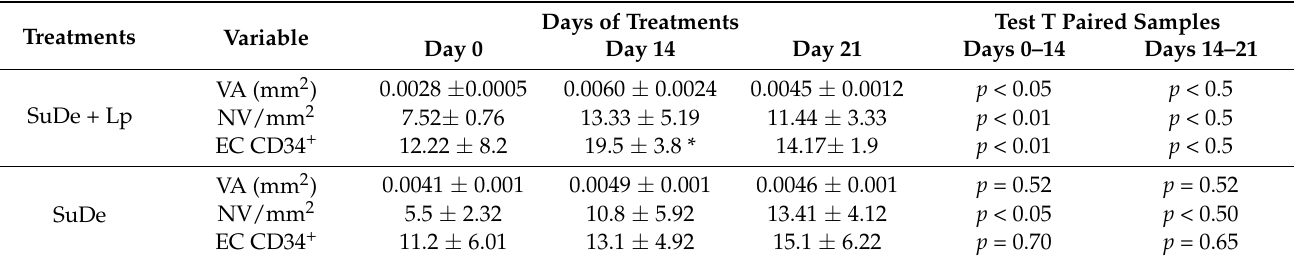
Table 2. Immunohistochemical staining of samples with anti-CD34. VA: vascular area, NV: number of vessels, EC: CD34 + endothelial cells. * p < 0.05 when comparing CD34 + cells in SuDe + Lp vs. SuDe groups.